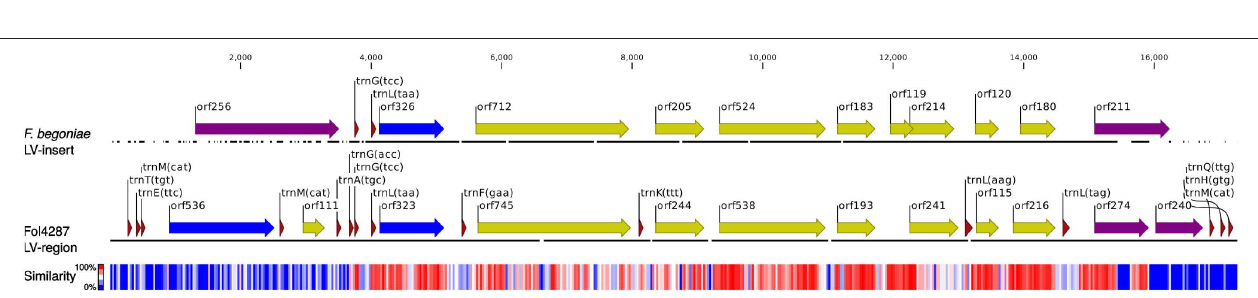
FIGURE 3 | Sequence comparison of cob-i393 of F. sacchari against cob-i393 of F. ficicrescens and mitogenome segment of F. proliferatum containing atp9 . Conserved atp9 shown as a blue arrow, while intronic coding sequences are shown as yellow arrows.